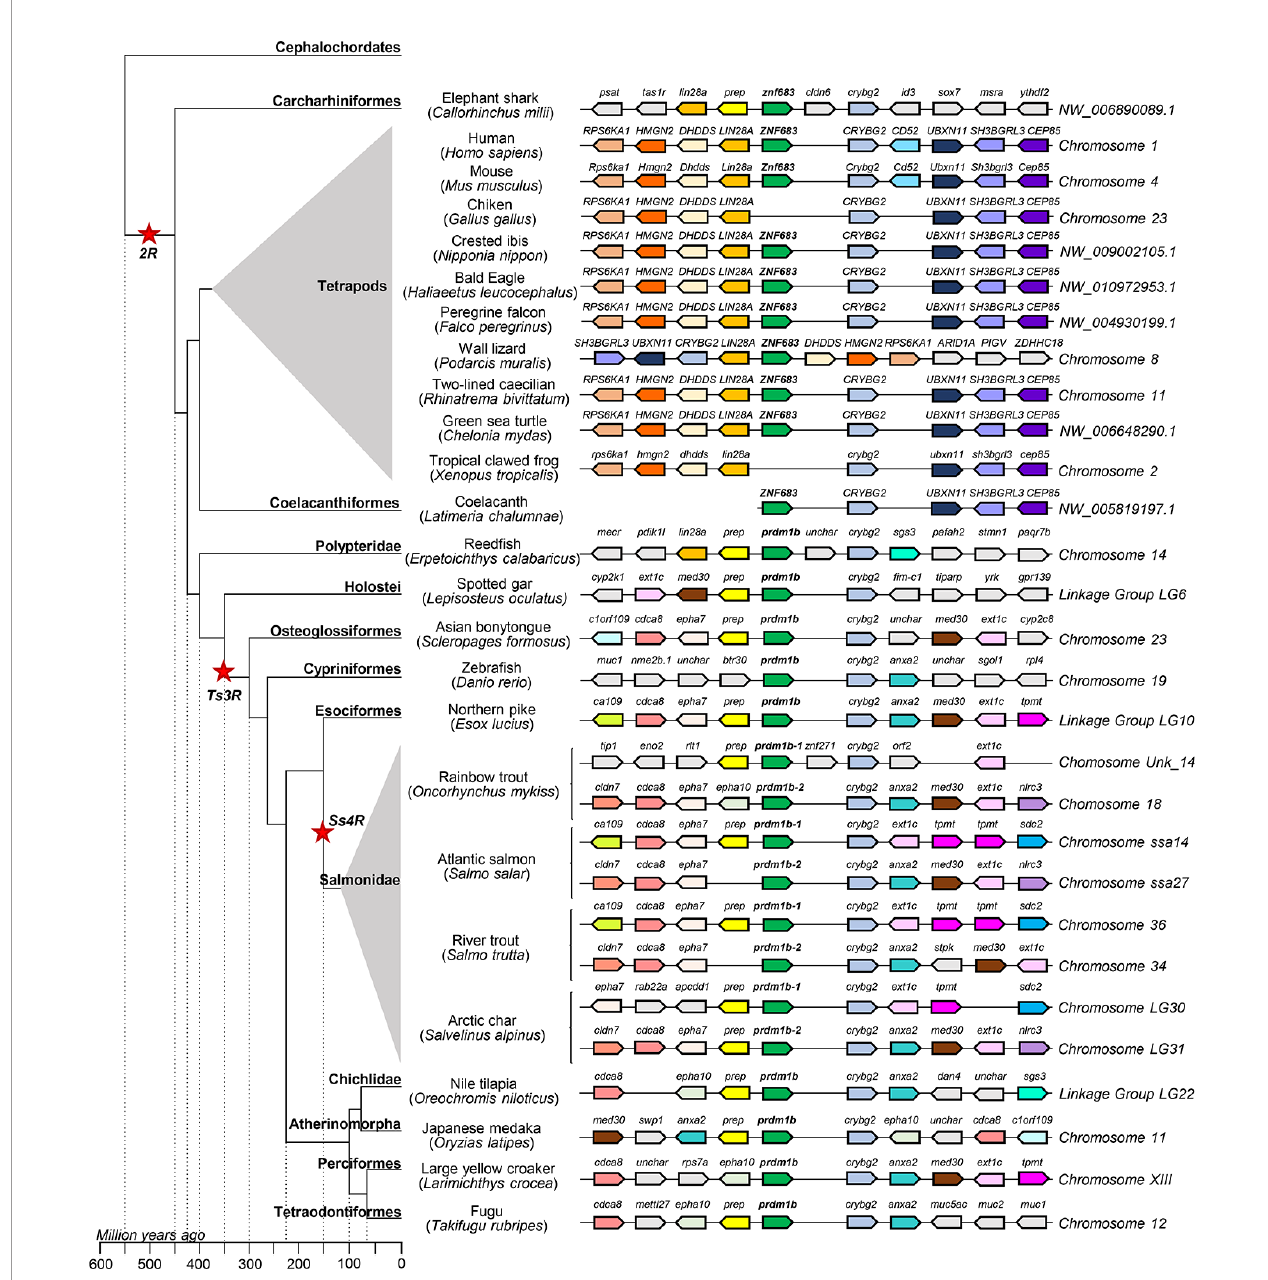
FIGURE 4 | Synteny analysis of the prdm1b group from O. mykiss associated to phylogenetic reconstruction. Different genes are represented by different colored arrows. The prdm1b neighboring genes were identi fi ed along different genomes available in the RefSeq database. Nonconserved genes along the fi gure are shown in gray. Arrows indicate the gene direction relative to prdm1b